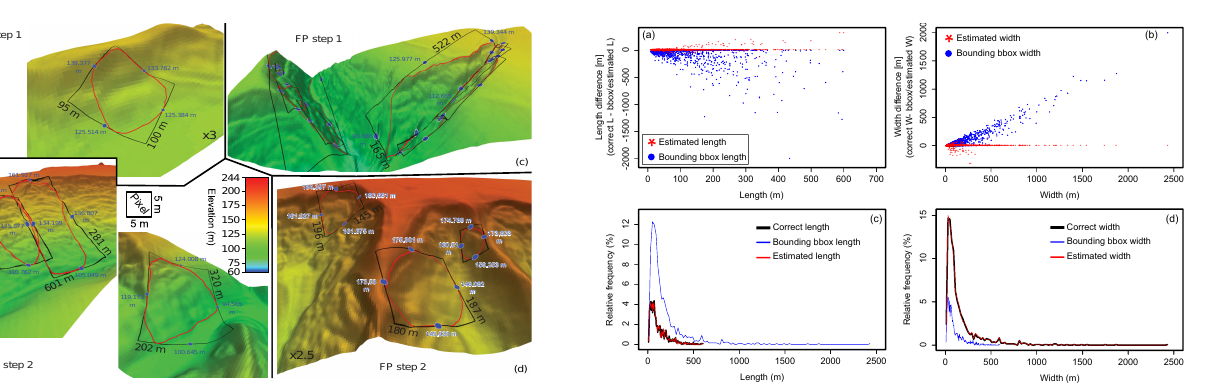
Figure 8. Plots of the difference between the real length/width, length/width of the oriented bounding box and length/width esti- mated with the proposed algorithm: (a) scatter plot of the difference between correct length and the bbox/estimated length, (b) scatter plot of the difference between correct width and the bbox/estimated width, (c) histograms of the three types of lengths and (d) his- tograms of the three types of